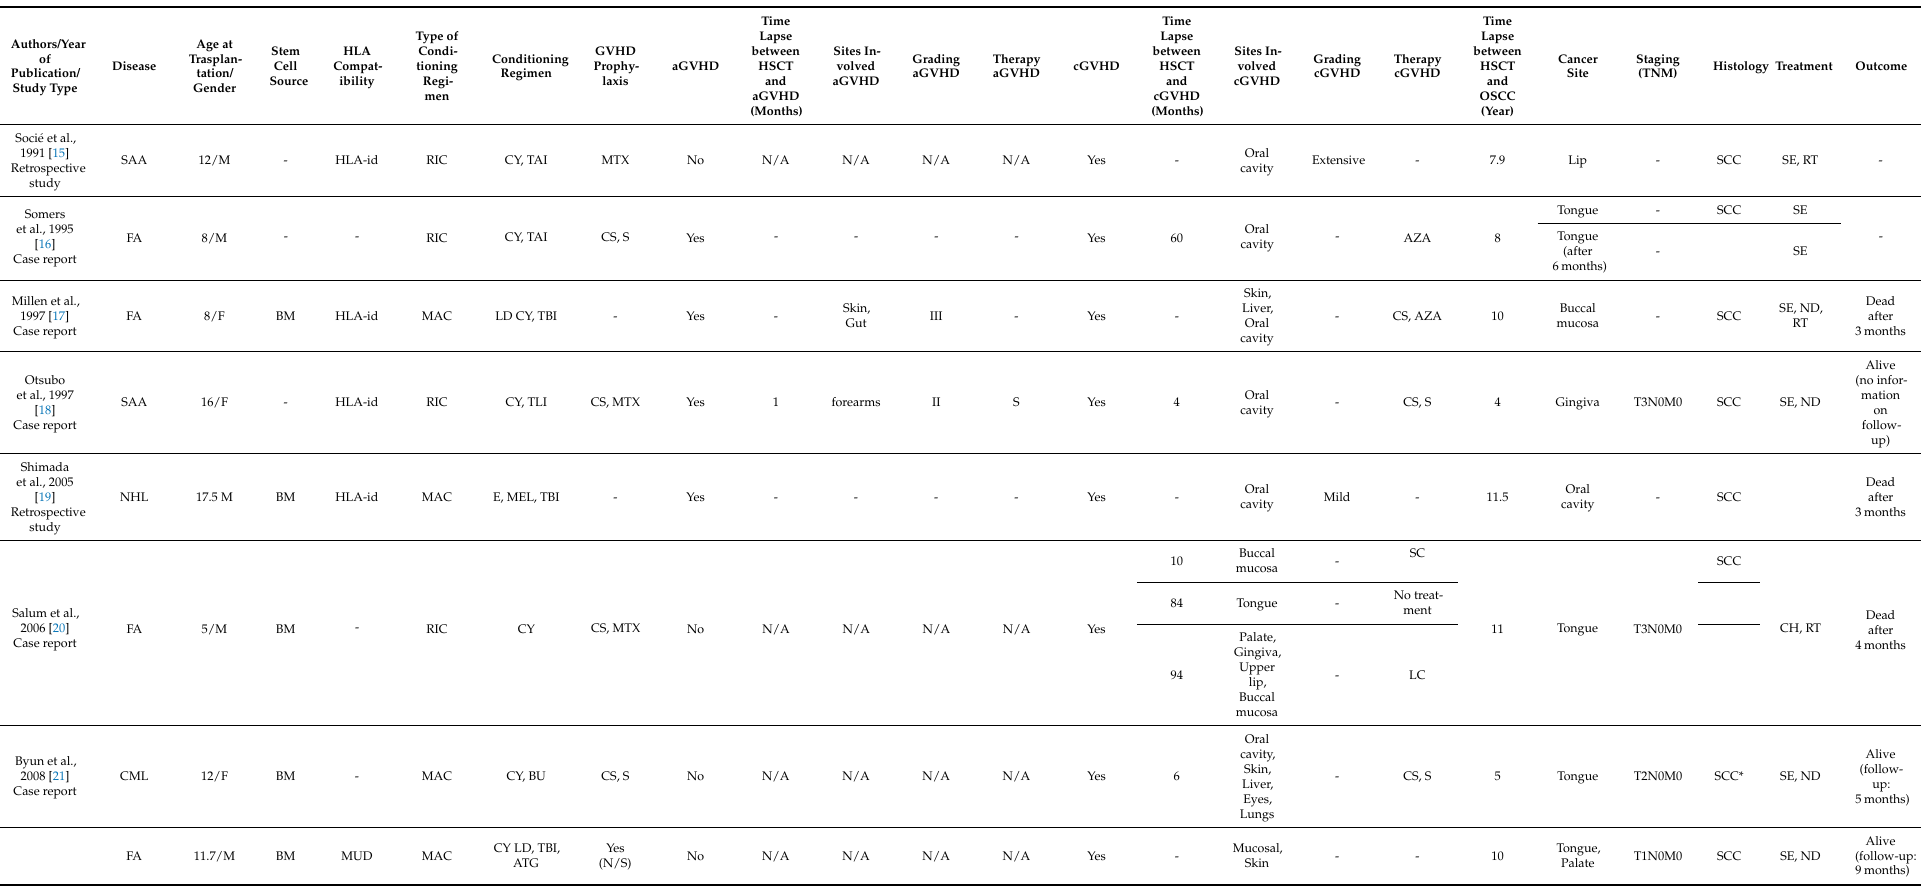
Table 1. Published data about oral cancer among pediatric patients affected by GVHD after